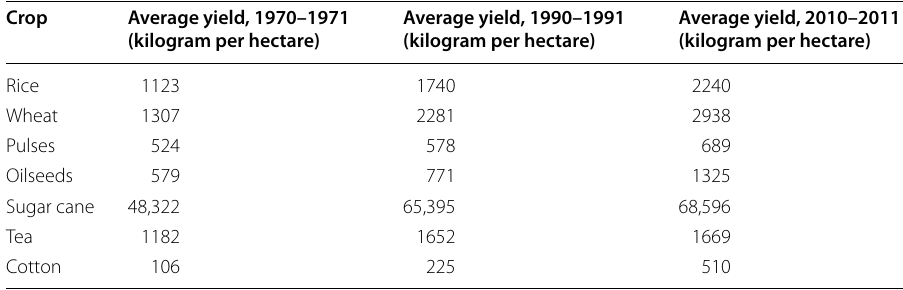
Table 4 Agriculture productivity in India, growth in average yields from 1970 to 2010. Source : Government of India, Area and Production of Principal Crops in India (various issues), Ministry of Agriculture